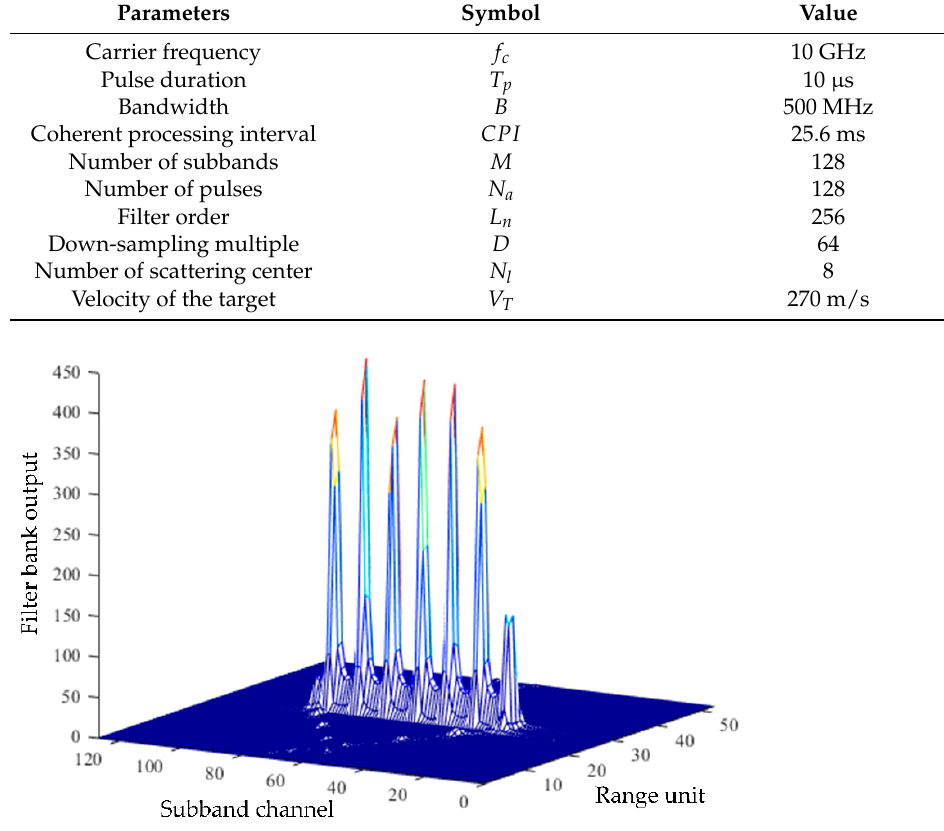
Figure 15. Signal after variable-scale transformation filtering.